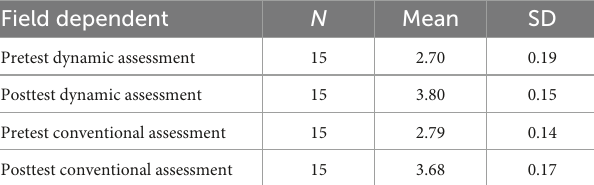
TABLE 2 Descriptive statistics for pretest and posttest mean scores of Field Independent learners with dynamic and conventional assessment.